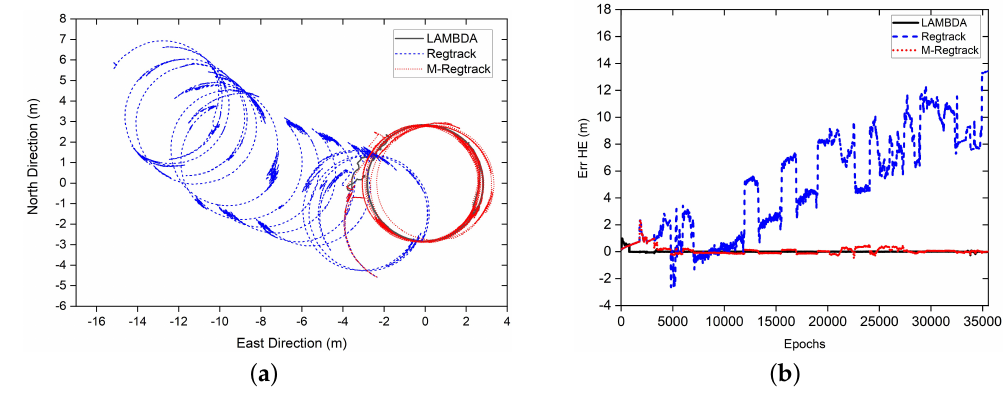
Figure 6. Relative tracking results and corresponding horizontal errors. ( a ) The relative tracking result of one receiver to another (both receivers are moving). ( b ) Horizontal error result, in which the distance between two receivers is 2.82 m, where HE =